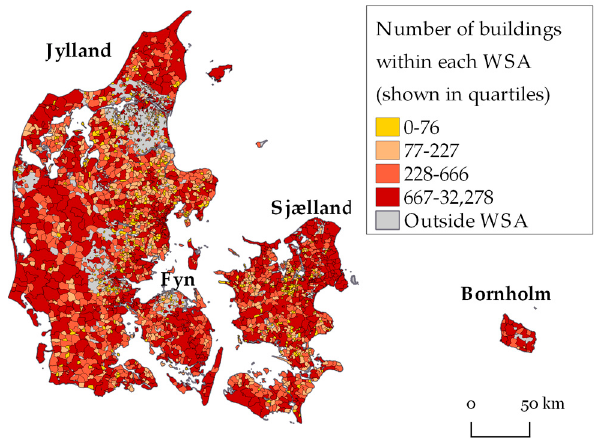
Figure 1. Public water supply areas (WSAs) ( N = 2813 WSAs) in Denmark colored according to number of buildings within each